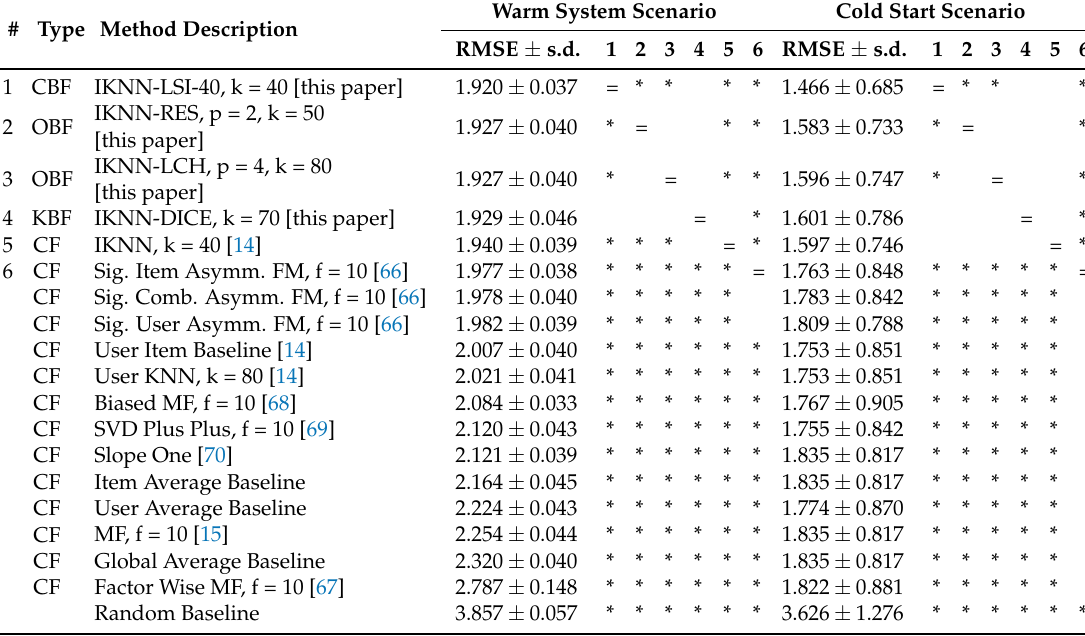
Table 4. Performance comparison between the best IKNN (item K-nearest neighbors) models and other CF (collaborative filtering) approaches in the Warm System and Cold Start evaluation